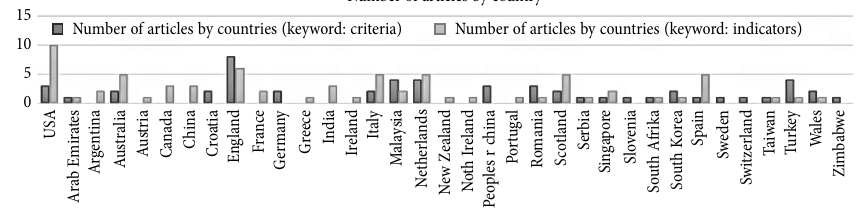
2012 2014 Fig. 2. Review of articles on the sustainable built environment by years using the keywords “criterion” and “indicator” Number of articles by